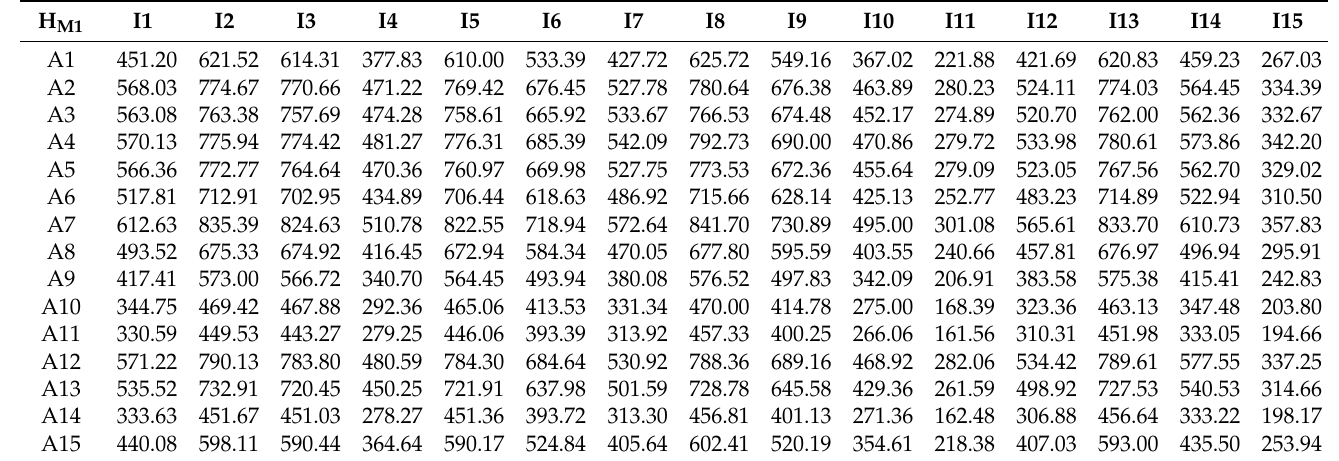
Table A3. Integrated relational matrix by considering three matrice (H M1 ).